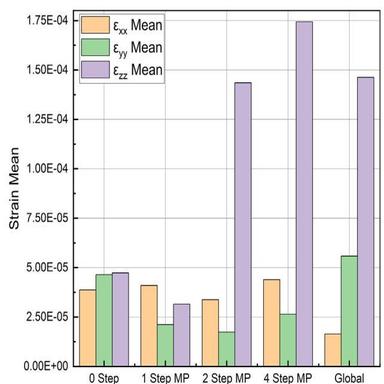
The change in calculated mean strains for repeat scans using different steps (0 to 4) in multi-pass (MP) method embedded in the local DVC analysis, as compared with those derived with the global DVC analysis.